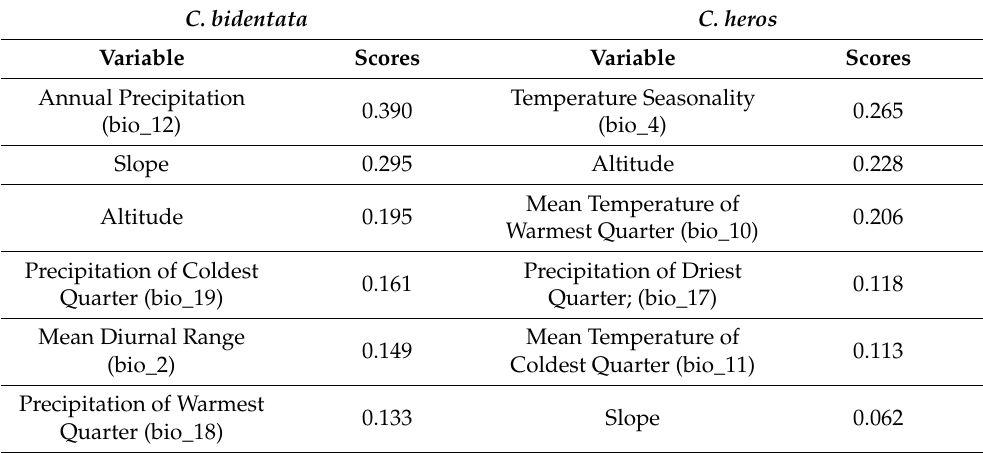
Table 1. Permutation-based variable importance scores sorted by their